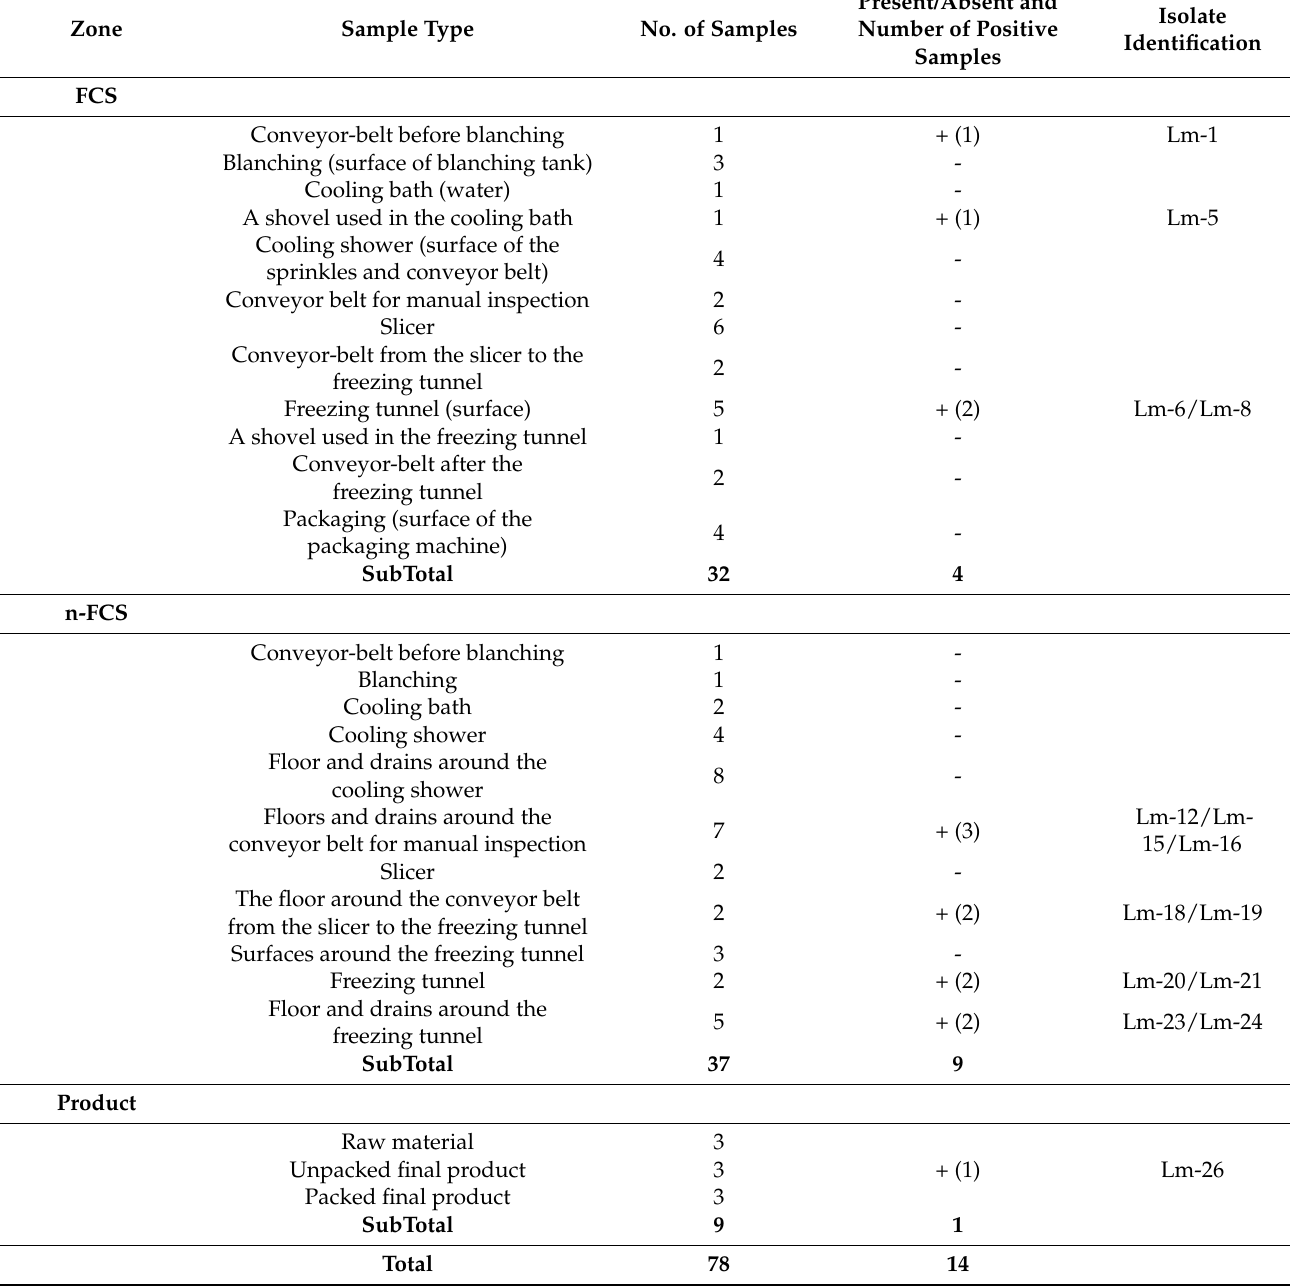
Table 1. Description of the zones, location, sampling site, number of samples, presence/absence of L. monocytogenes and isolate